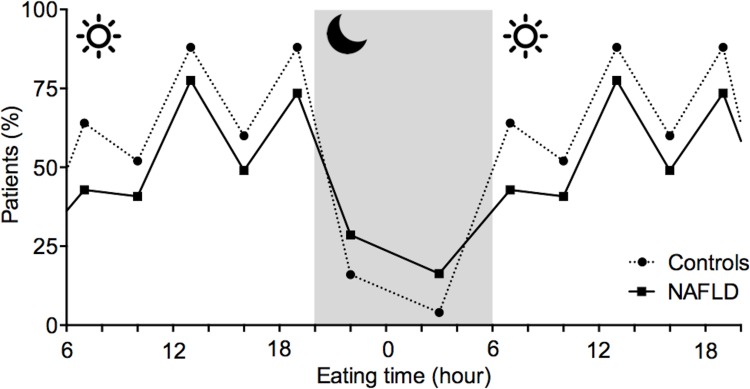
Timing of food-intake differs between NAFLD patients and controls.The percentage of patients vs. controls having meals at different times during the day and night. Compared to controls meal times in NAFLD patients were shifted towards the night (p = 0.001, generalised linear mixed model). Controls (n = 22); NAFLD (n = 44).